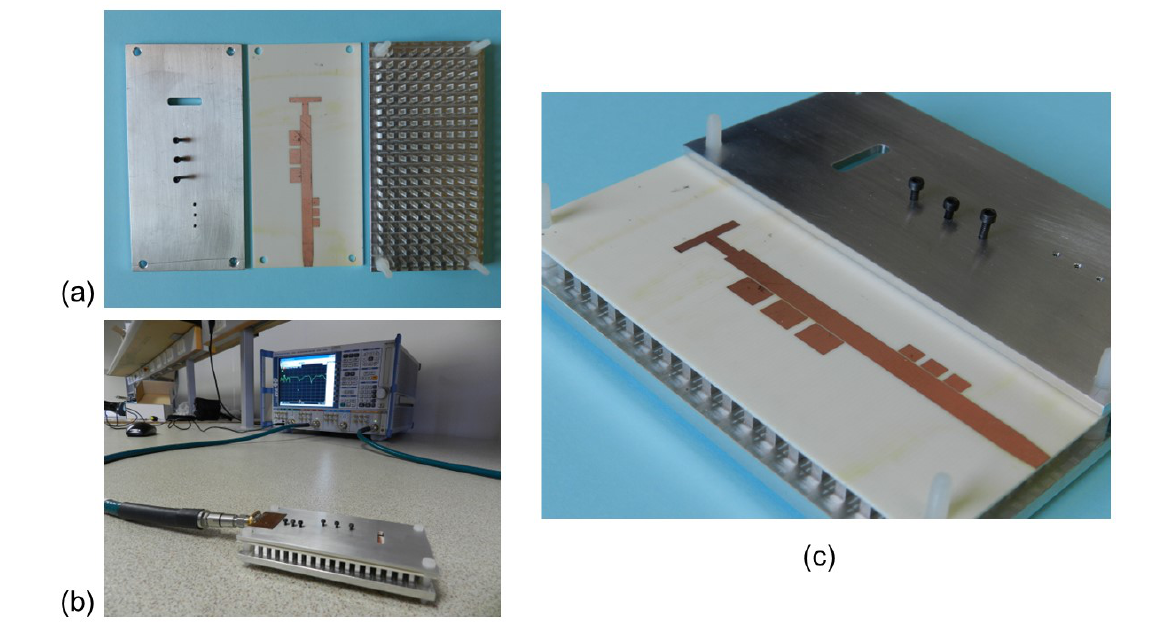
Figure 18. Photograph of the fabricated filtering antenna: ( a ) Front view of the layers (unstacked). ( b ) | S 11 | antenna test setup. ( c ) Perspective view with the detail of the printed layer with the resonators and the slot feeder and the threads for the screws on the top plate.